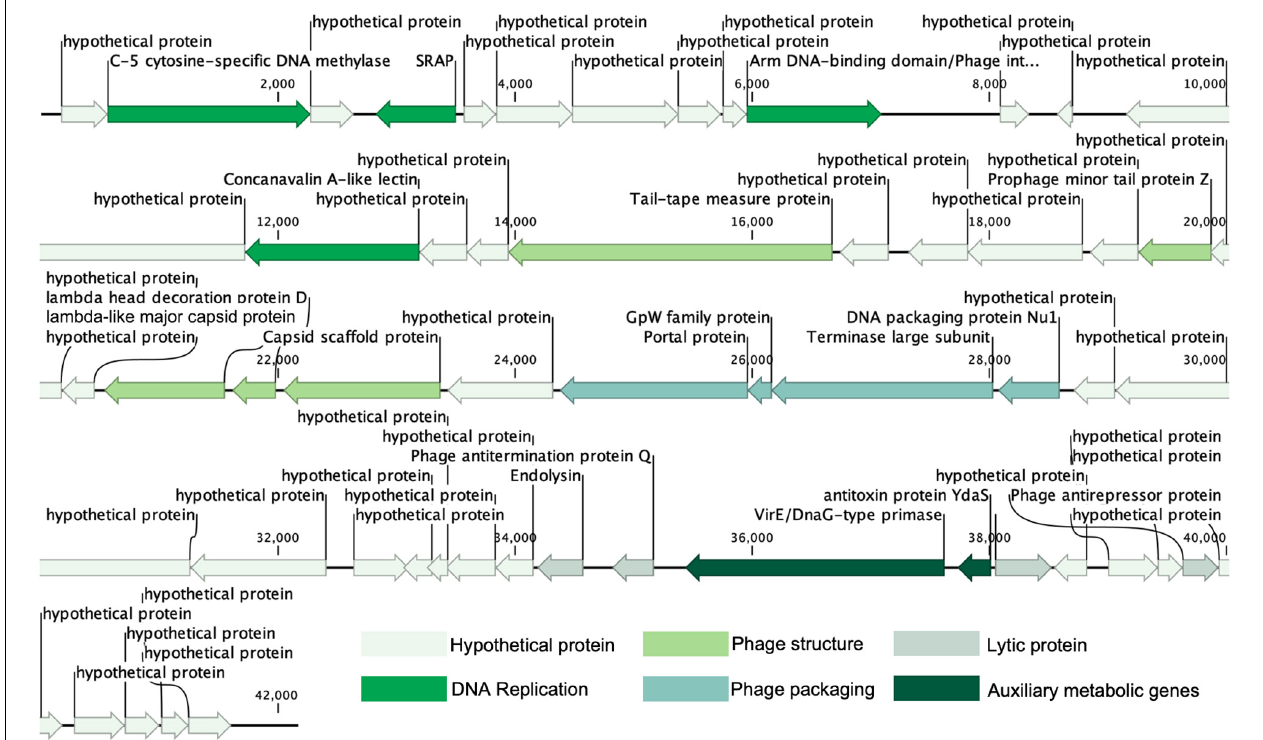
FIGURE 2 | Genome map and functional annotation of the predicted proteins of vB_MalS-PS3.